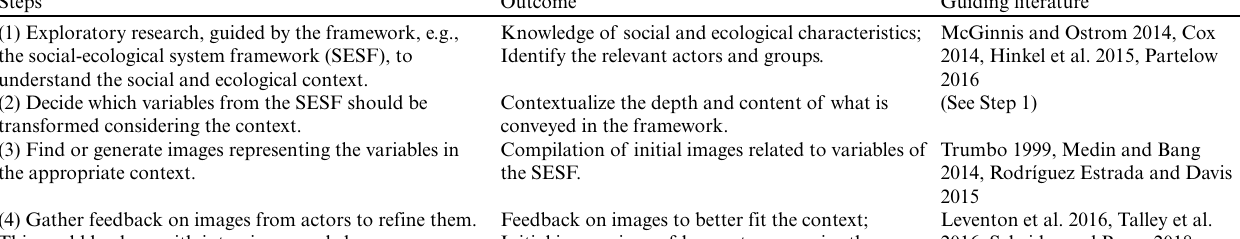
Table 2 . Methodological steps developing an image-based deliberation tool from a social-ecological system (SES) framework. Steps Outcome Guiding